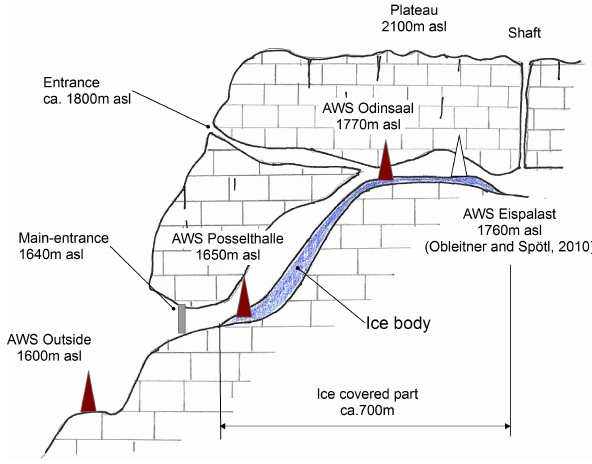
Fig. 2. Schematic of cross section of ice covered part of Eisriesen- welt cave with location of the 3 AWSs (Outside, Posselthalle unten and